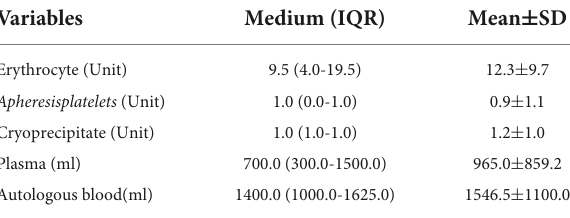
TABLE 3 The transfusions of blood products in operation.